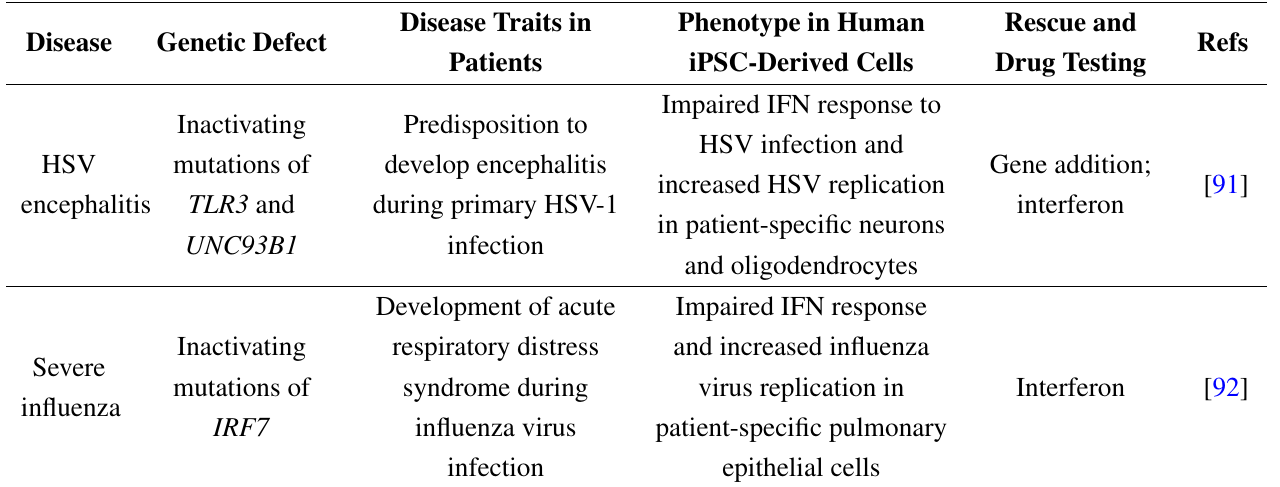
Human induced pluripotent stem cell (iPSC)-derived models of genetic susceptibility to viral infectious diseases.